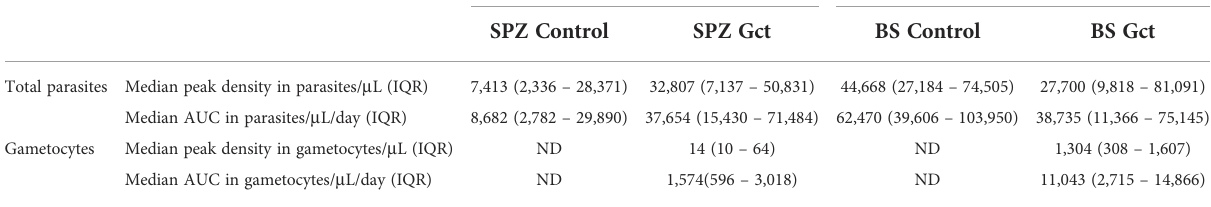
TABLE 1 Parasitaemia and gametocytaemia for different